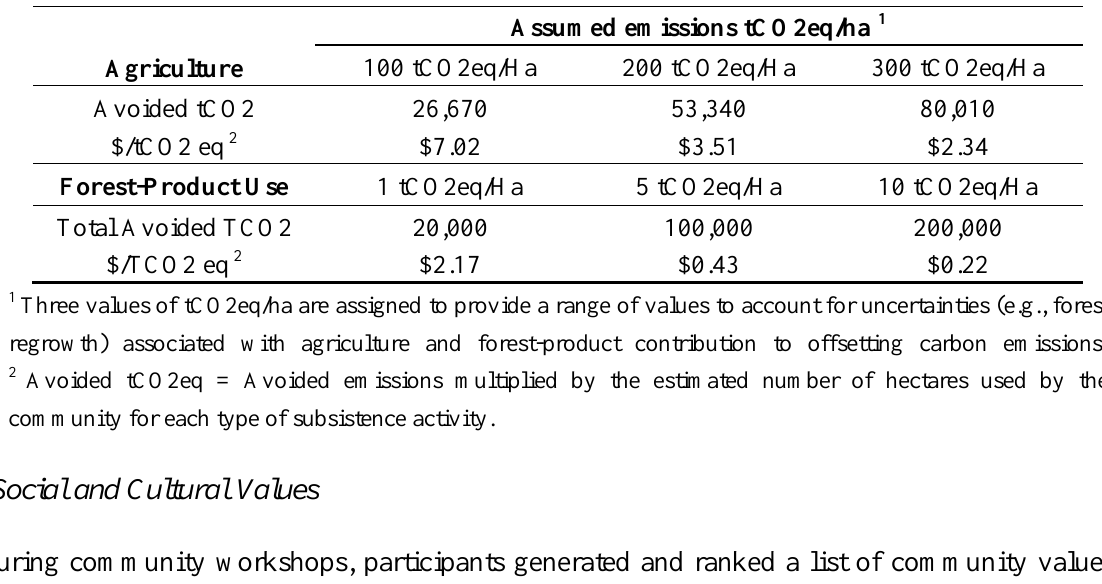
Table 4. OCA of avoided tCO2eq. from subsistence